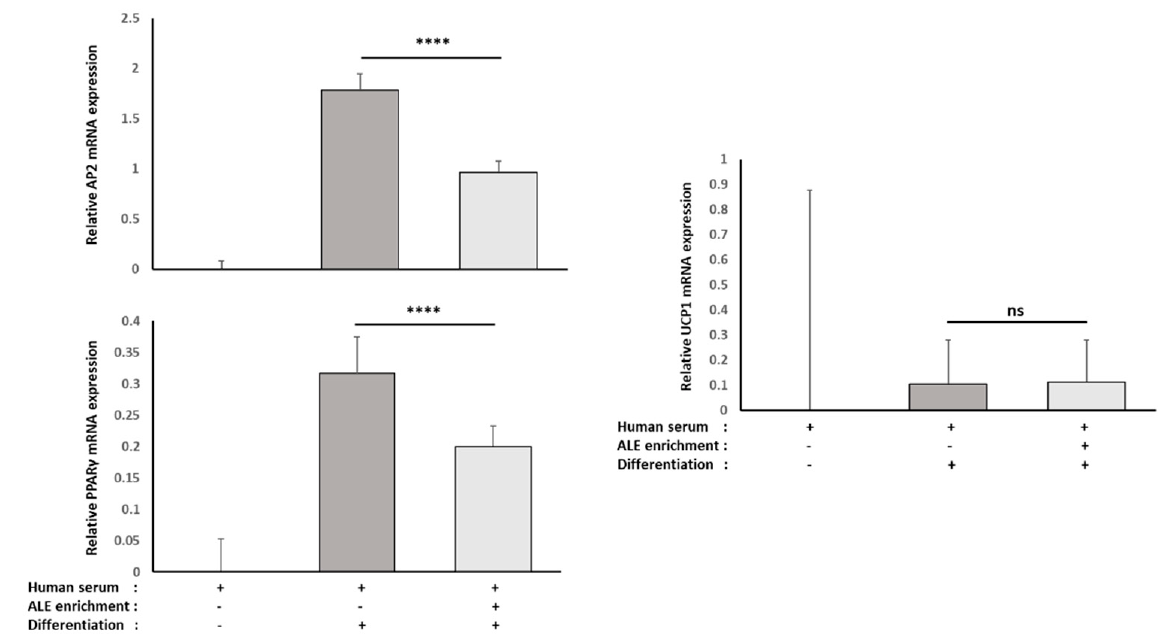
Figure 10. Effect of human serum enriched with ALE metabolites on AP2, PPAR γ and UCP1 mRNA expression levels in primary human subcutaneous pre-adipocytes: Primary human subcutaneous pre-adipocytes were differentiated for 8 days in the presence of human serum enriched with ALE metabolites. AP2, PPAR γ and UCP1 mRNA expression levels were measured by RT-PCR (PowerUp SYBRgreen, Applied Biosystems). β -Actine was used as a housekeeping gene. Primers were designed as follows: AP2-F: ATC ACA TCC CCA TTC ACA CT; AP2-R: ACT TGT CTC CAG TGA AAA CTT TG; PPAR γ -F: GGA TTC AGC TGG TCG ATA TCA C; PPAR γ -R: GTT TCA GAA ATG CCT TGC AGT; UCP1-F: GTC TGC CTT GAC TTT GAC AGT; UCP1-R: AGG ACC AAC GGC TTT CTT C; ACTB-F: ATT GGC AAT GAG CGG TTC; and ACTB-R: GGA TGC CAC AGG ACT CCA. Both AP2 and PPAR γ mRNA expression were significantly reduced by the presence of ALE metabolites in differentiated cells. Based on UCP1 mRNA expression, the reduced white adipocyte differentiation did not involve a switch toward brown adipocyte differentiation. **** ( p < 0.0001); ns : no significant